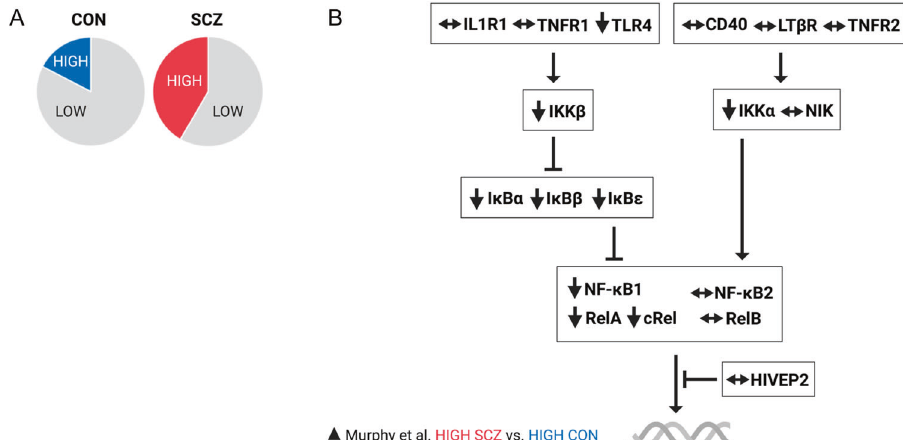
Fig. 5 Expression of NF- κ B transcripts in the postmortem DLPFC of schizophrenia patients with neuroin fl ammation relative to non- schizophrenic controls with neuroin fl ammation. A Not all patients show evidence of neuroin fl ammation (red = proportion of ‘ in fl amed ’ patients, grey = non-in fl amed patients), and some individuals without schizophrenia do show evidence of neuroin fl ammation (blue = ‘ in fl amed ’ controls, grey = non-in fl amed controls). Comparing cortical mRNA levels of NF- κ B pathway members between high in fl ammation patients and high in fl ammation controls allows for identi fi cation of schizophrenia-speci fi c abnormalities in this critical immunomodulatory pathway. B Such comparisons have shown that high neuroin fl ammation patients may actually have ‘ blunted ’ NF- κ B activation, which may represent cell-speci fi c de fi cits and/or a failure to adequately induce NF- κ B to the level required to initiate NF- κ B- dependent anti-in fl ammatory processes in the